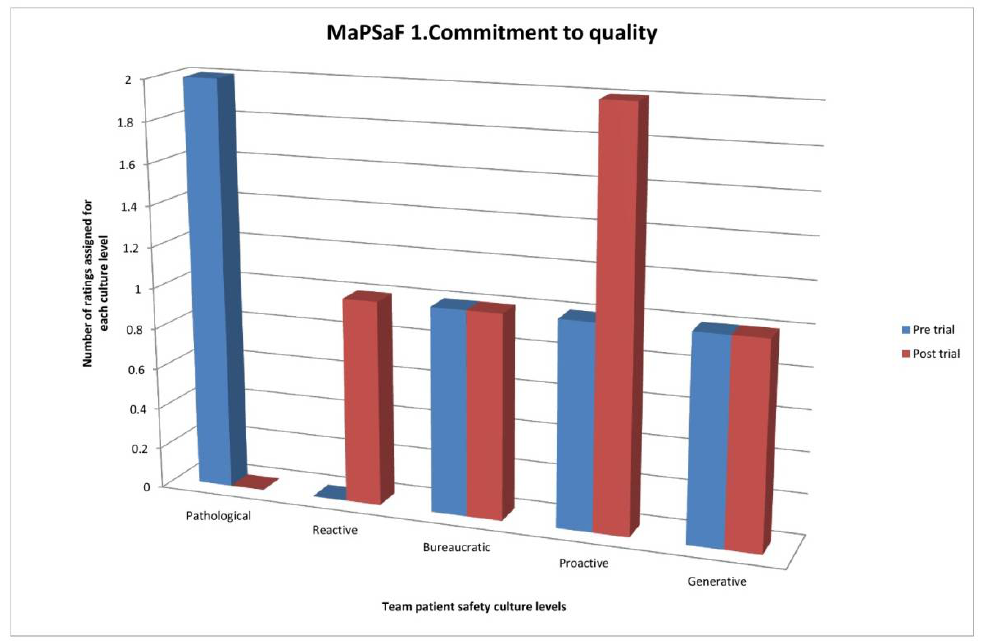
Figure 4. Manchester Patient Safety Framework (MaPSaF) Commitment to Quality.